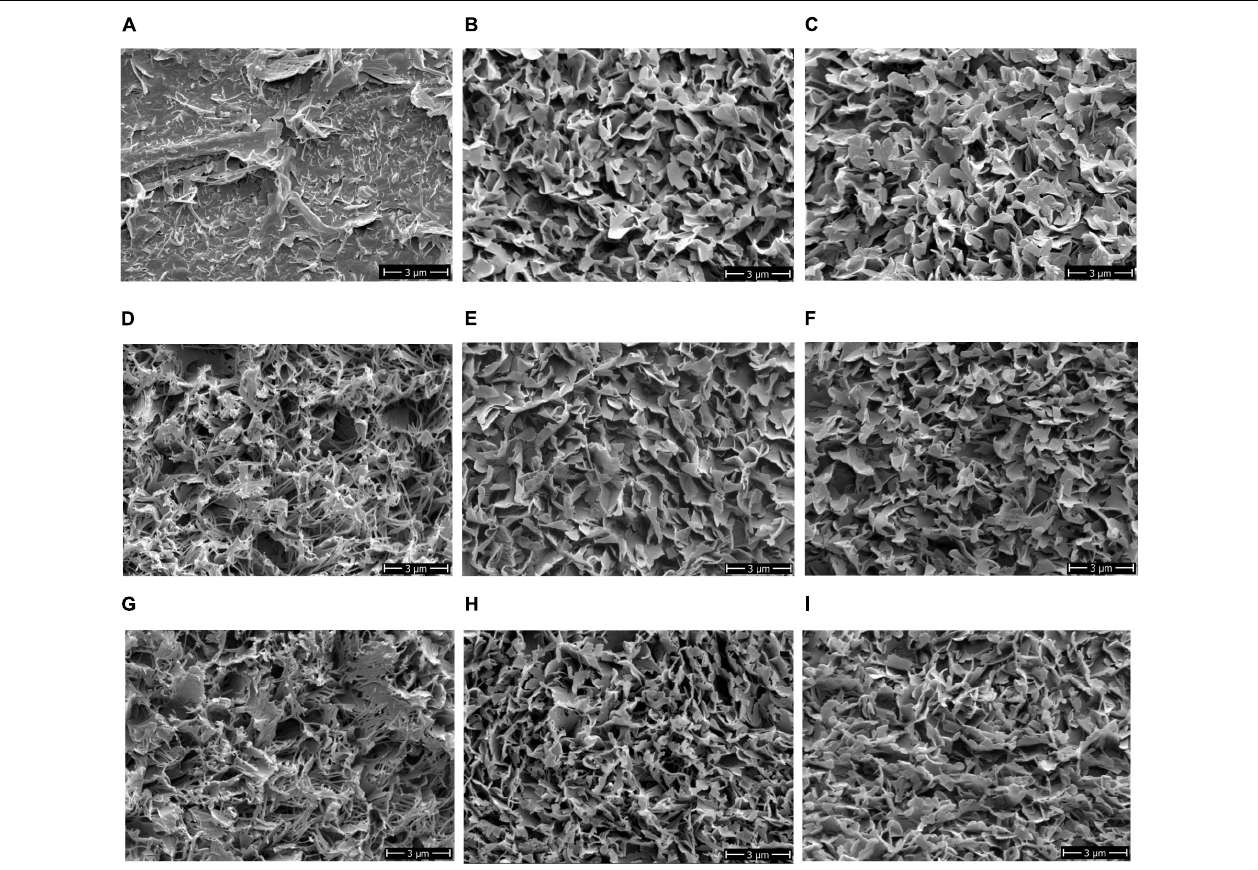
FIGURE 5 | Ultrastructural phenotype of the epicuticular waxes on the berry surfaces of different grapevine varieties. Exemplary images illustrate the structural differences: (A) ‘Morio Muskat,’ (B) ‘Riesling,’ (C) ‘Sauvignon Blanc,’ (D) ‘Calardis Blanc,’ (E) ‘Dakapo,’ (F) ‘Cabernet Sauvignon,’ (G) ‘Norton,’ (H) Seibel 7511, and (I) ‘Cabernet Blanc.’ Cryo-SEM 8,000x. SEM, scanning electron